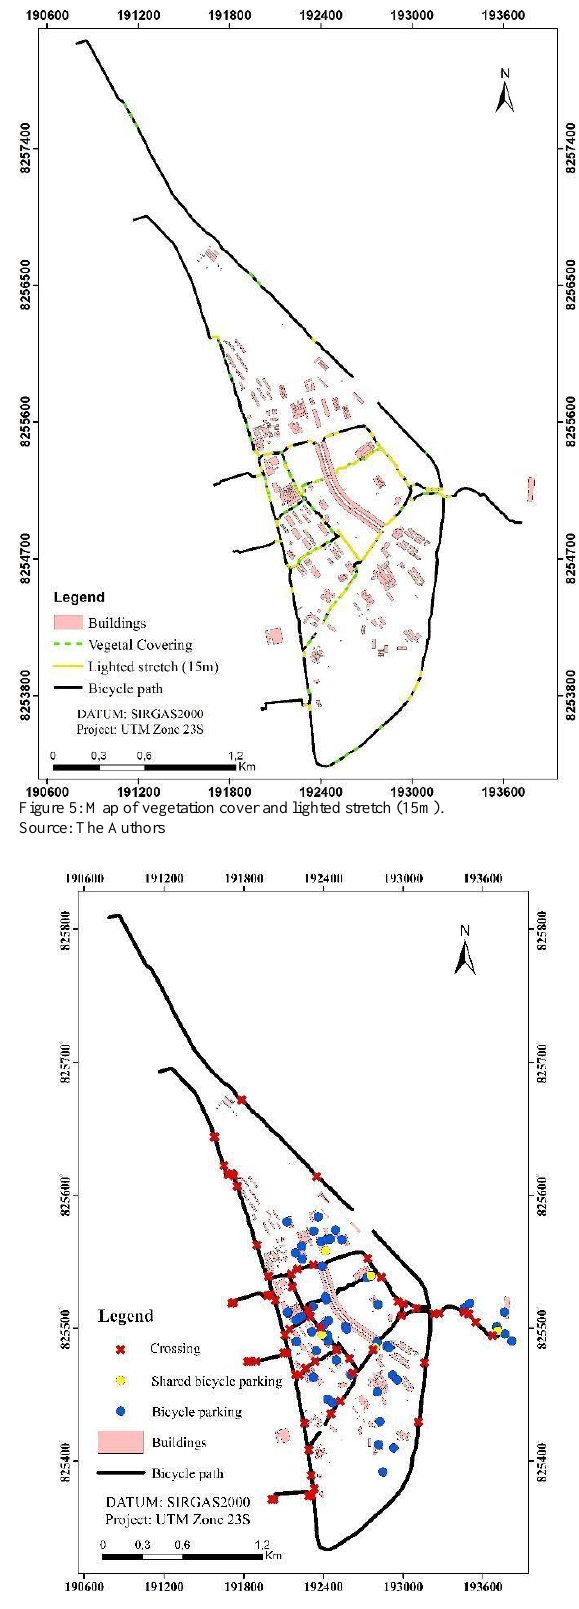
Figure 6: Map of crossing, shared bicycle parking and bicycle parking. Source: The